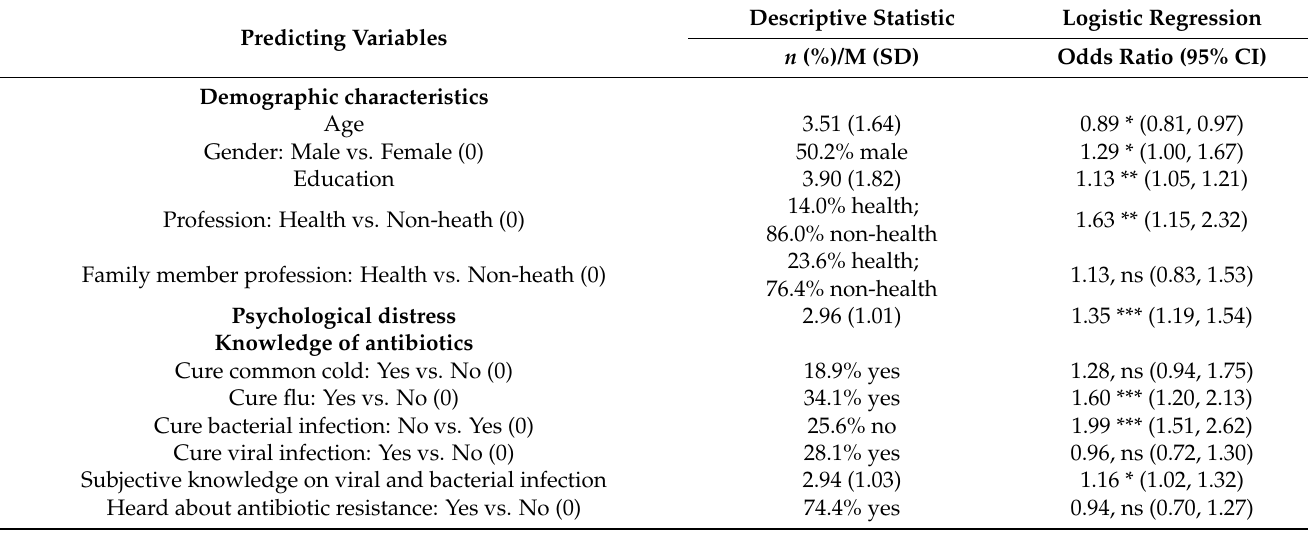
Table 3. Descriptive statistics, and Odds Ratio from logistic regression analysis of predictors on taking antibiotics for protection against COVID-19 ( n =